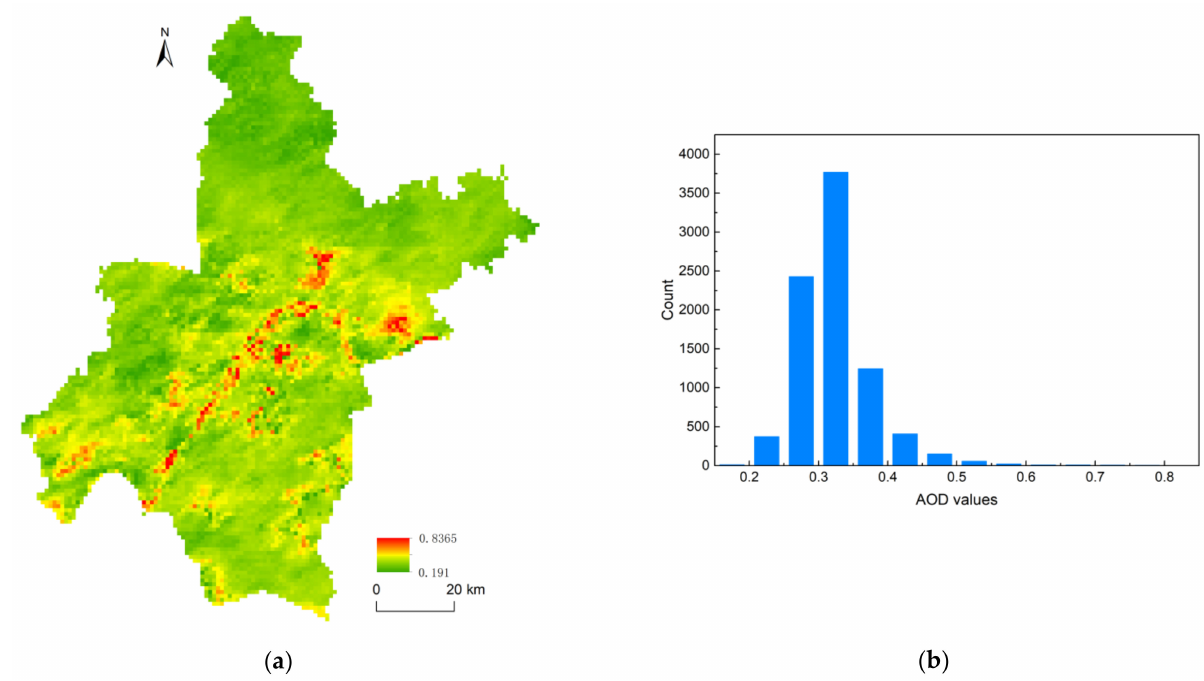
Figure 2. The distribution maps of AOD (Aerosol Optical Depth) values in Wuhan: ( a ) spatial distribution and ( b ) histogram